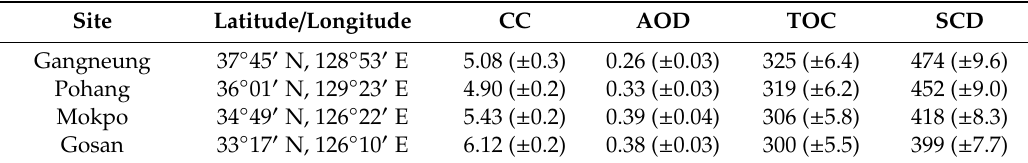
Table 1. Summary of geophysical information and annual average values for the attenuating factors (cloud cover (CC), aerosol optical depth (AOD), total ozone column (TOC), and slant column density (SCD)) during the analysis